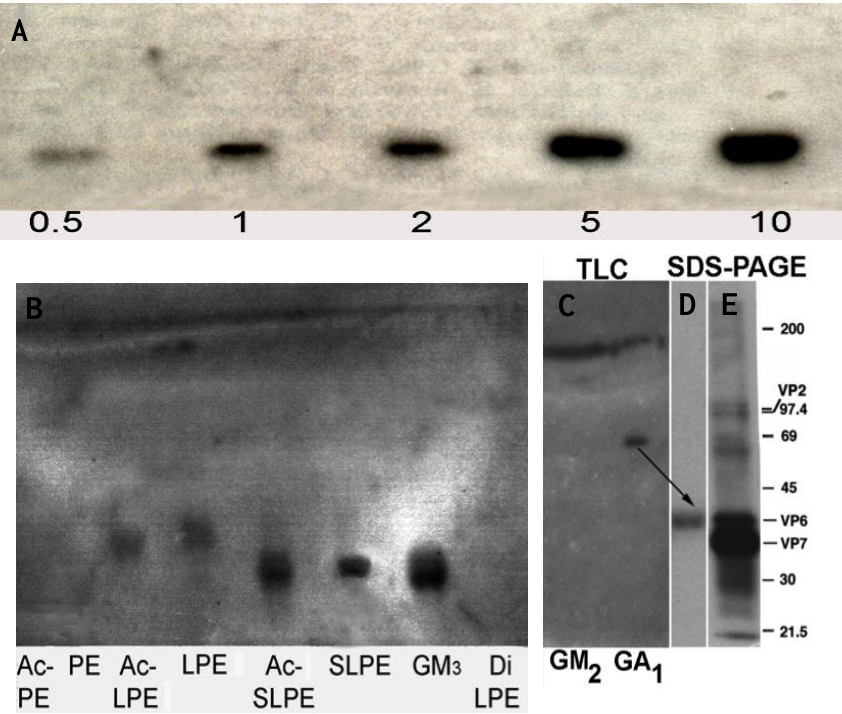
Figure 5. Binding of rotavirus to SLPE and LPE and their acetylated derivatives. Binding of rotavirus (TLP) to the indicated neoglycolipids and their acetylated derivatives was performed by TLC overlay and SDS PAGE as described in the Experimental Section. Panel A shows rotavirus binding to increasing concentrations (0.5–10 nmol) of SLPE. Panel B compares the relative binding affinity of [ 125 I]rotavirus TLP to SLPE, LPE and their acetylated derivatives. Panel C depicts the binding of purified [ 125 I]VP6 protein to GM and asialo-GM ganglioside (GA ). Panel D shows the electrophoretic mobility and 2 1 1 autoradiography of radioactive material recovered from the band (arrow) scraped from the GA lane of the TLC plate in Panel C. Panel E shows the separation and visualization of 1 [ 125 I]rotavirus TLP proteins by SDS PAGE and autoradiography. Note the GA binding 1 radioactivity recovered from Panel D co-migrates with rotavirus VP6 capsid